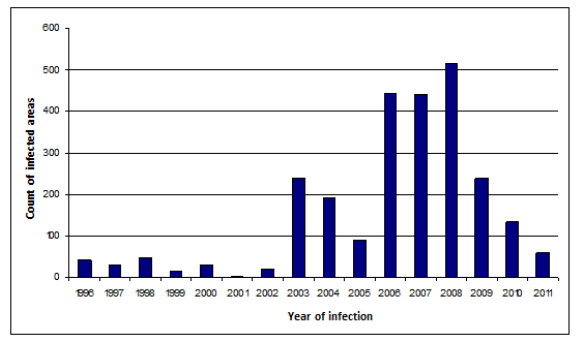
Figure 12. Overview of number of infections per year During the pre-processing different terrain information was derived, e.g. slope, aspect, location on a slope, the topographic wetness index, and the hill shade with defined angle of solar incidence as a parameter for the amount of solar radiation and temperature. Soil data were processed to generate maps differentiating between fine grained and coarse grained soils and wetness classes. For the forest stand the parameters height, density of stand and general location with regard to the forest outskirt have been